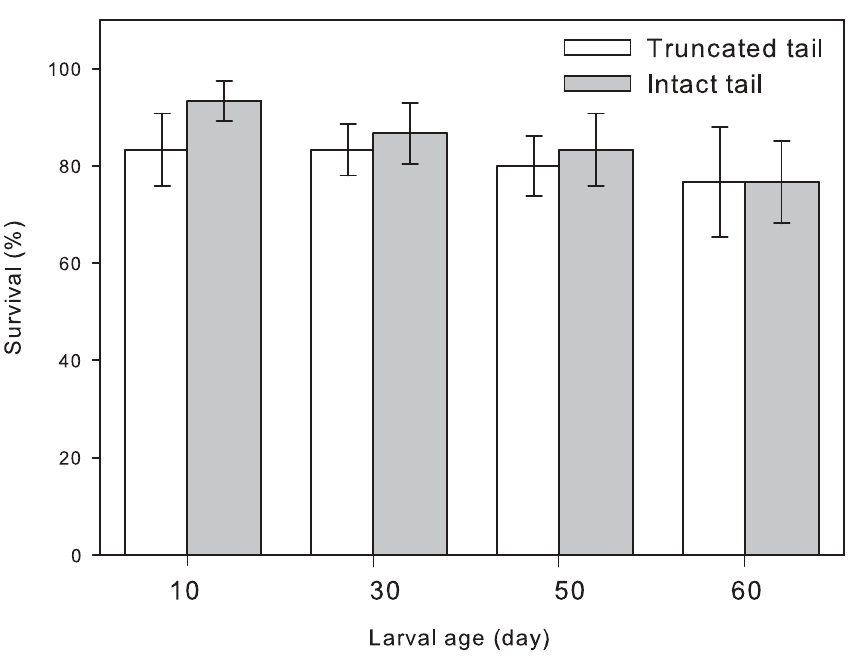
Fig 2. Tail regeneration rate per day of Salamandra infraimmaculata larvae versus larval age (day) at the time of tail clipping (N = 16). A polynomial 2 nd degree curve explained 48.3% of the variation in the data (F 2, 13 = 6.07, p =